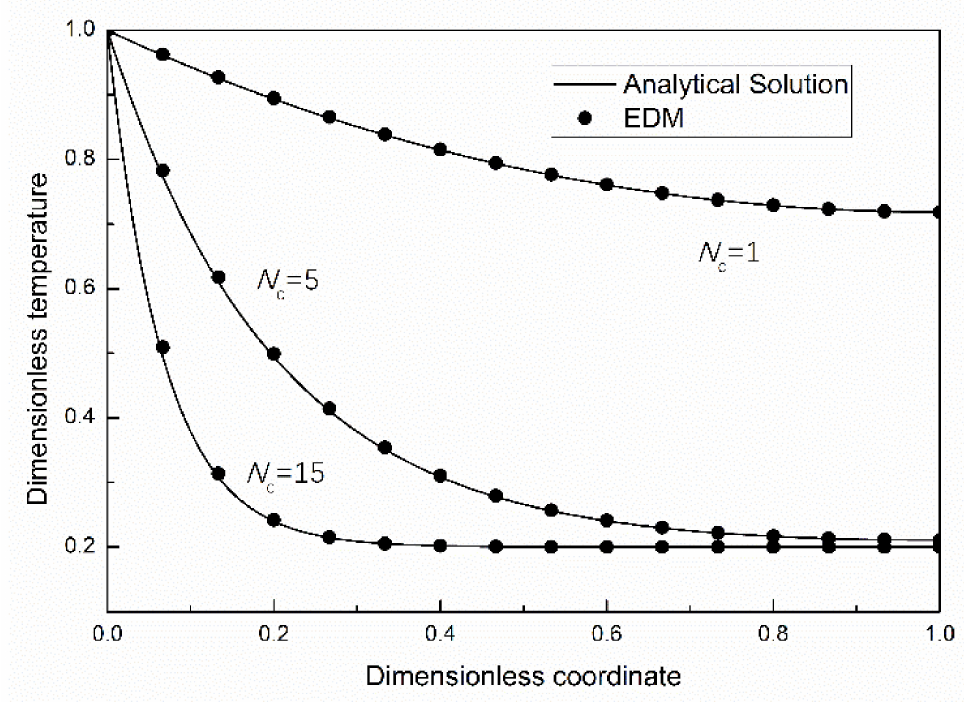
Figure 3. Comparison of dimensionless temperature by the EDM and analytical